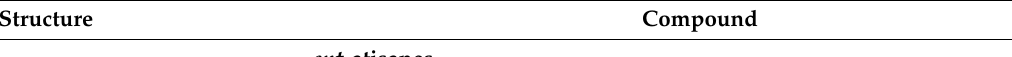
Table 1. Cont. Structure Compound ent